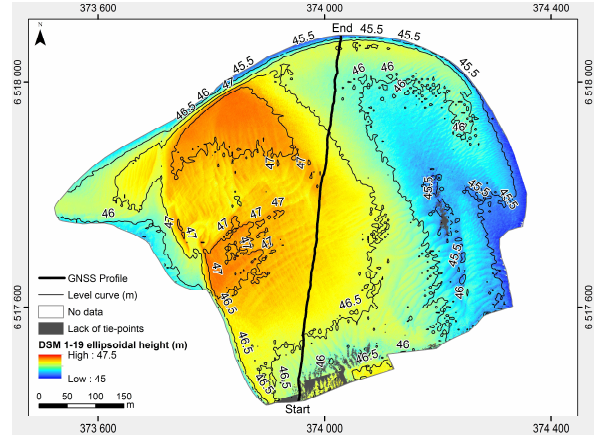
Figure 11. DSM 1-19 from flight 1 focused on the sand